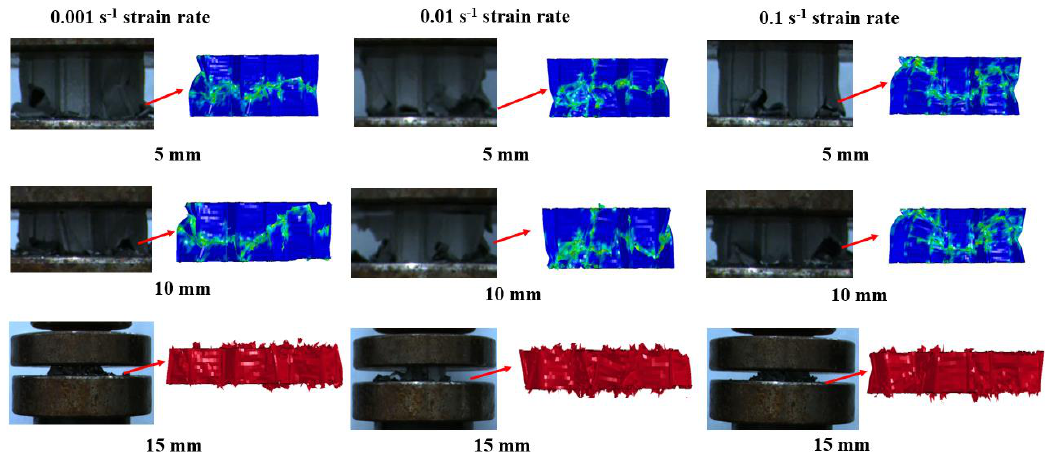
Figure 9. The crushing process of BHTS – II under various strain rate loading.